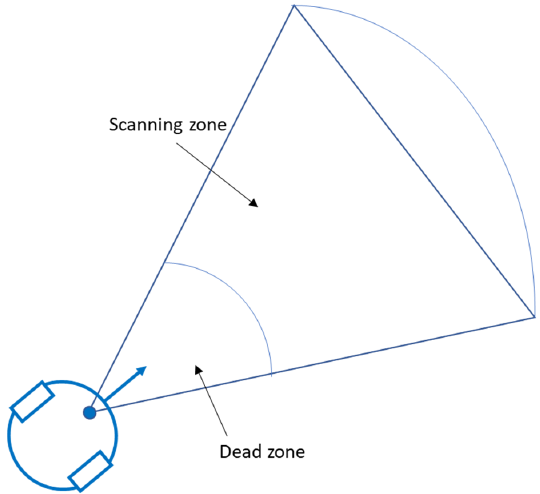
Figure 10. Illustrating dead zone and scanning zone of the robot.